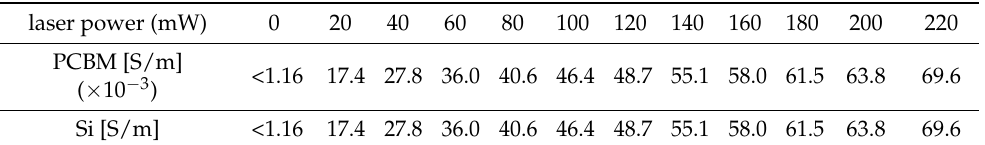
Figure 5. Carrier concentrations, obtained with the simulation results, of photo-induced electrons in the PCBM thin film and photo-induced holes in the Si substrate. Table 1. Values of electrical conductivity used for carrying out simulations at different laser powers of the incident optical beam employed for